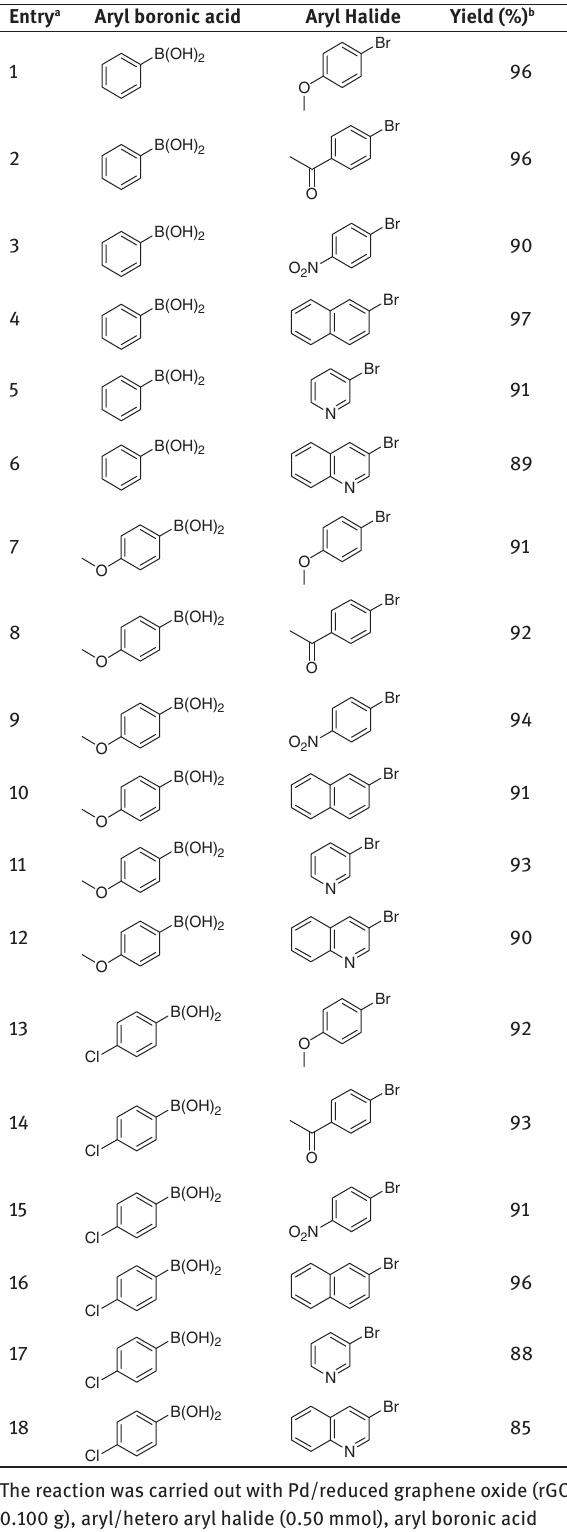
Table 2: Pr/reduced graphene oxide (rGO) catalyzed Suzuki cross coupling reaction of aryl halides with aryl boronic acids in [bmim]NTf